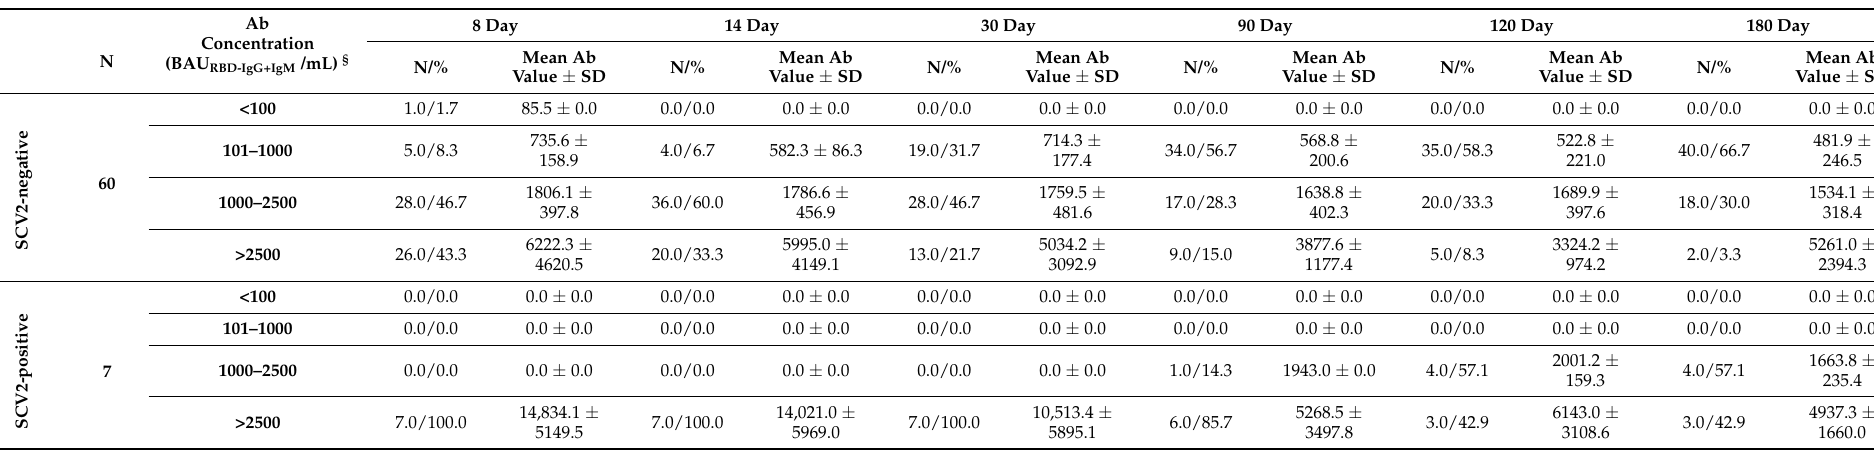
Table 2. The number, the percentage of participants, and the mean antibody (Ab) level at SCV2-negative and SCV2-positive group after the second vaccine